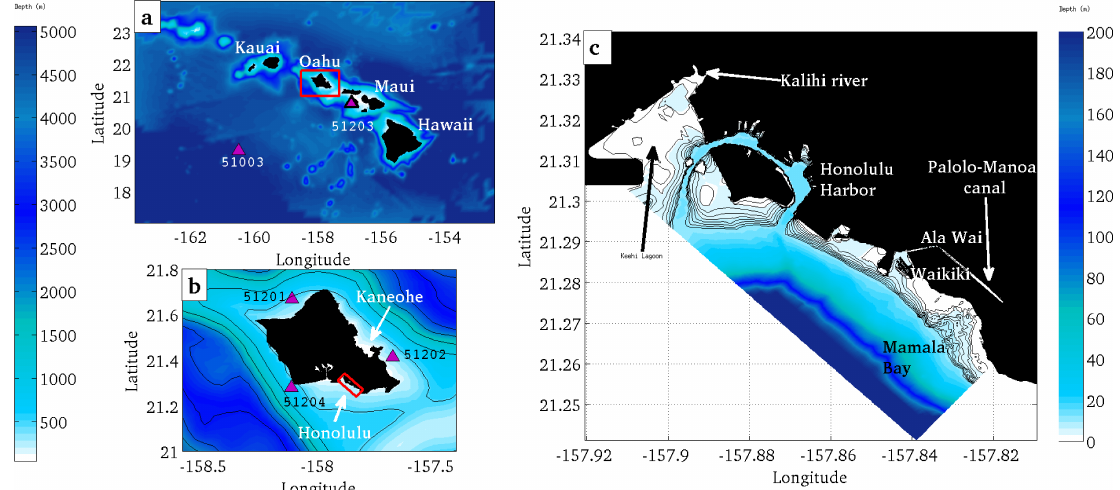
Figure 1. Bathymetry map of the (a) Hawaiian Islands, with the island of O’ahu highlighted by the red rectangle and shown in detail in the map (b) (contour interval 500m). The numerical grid used in the present work ( ≈ 50m resolution) is highlighted by the red rectangle in (b) and expanded in (c) , with the black contours corresponding to the isobathymetric lines every 1m from the coast to the depth of 10m. It is possible to observe the intricate bathymetry near the coast of Honolulu associated with the coral reefs. The purple triangles indicate the positions of the NDBC buoys around Hawaii, which are used to validate the wave numerical model